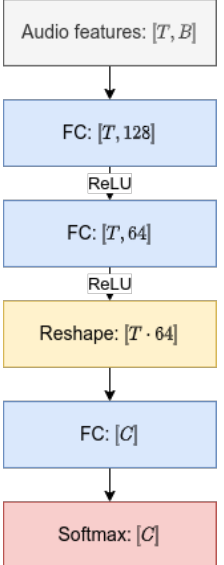
Figure 1. The scheme of the feedforward neural network used in our experiments. The shape of the resulting tensor is specified after each block in square brackets. FC stands for the fully-connected layer. T is the number of frames in a sample (98 in all our experiments). B is the number of channels in the audio features (80 for log-Mel filter banks, 512 for wav2vec features). C is the number of classes to